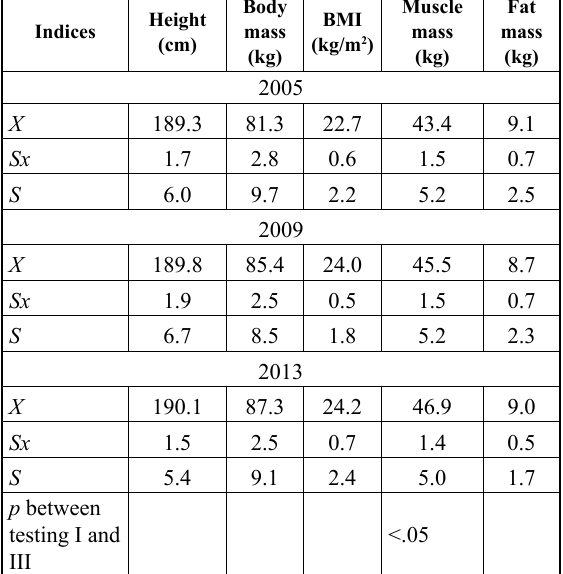
Table 1. Body development indices of Lithuanian deaf basketball national team members in 2005, 2009 and